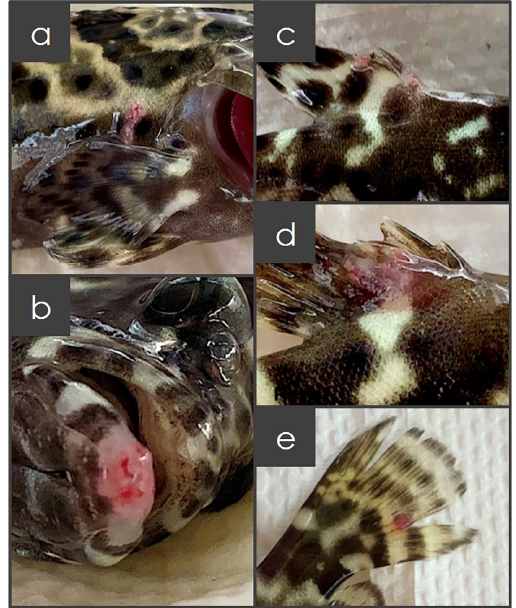
Figure 1. Development of ulcer and lesions on the body ( a ), mouth ( b ), anal fin ( c ), dorsal fin ( d ) and caudal fin ( e ) of hybrid grouper that were susceptible to Vibrio alginolyticus experimental infection, comparable to the resistant hybrid grouper where no observable ulcer and lesion were recorded. The infection of V. alginolyticus on the selected healthy hybrid grouper was confirmed by applying the bacteria plating method. The fish mucus from resistant and susceptible groups was spread individually on marine agar and TCBS agar to confirm the presence of Vibrio in the fish. All the subjected samples, including the spleen of the dead fish, showed positive for Vibrio infection on the TCBS agar (Appendix A Figure A1). However, the bacterial load was not quantitatively analyzed. The immersion in the same concentration of bacterial suspension in controlled conditions and exposure time might have given similar bacterial exposure to the fish. The evaluation on the skin mucus protein of the susceptible and resistant groups showed viscosity variation. The susceptible group secreted much more and a viscous mucus than the resistant fish. The protein composition of the skin mucus between the infected group and control group was significantly different with the former showing more variable intensities of the protein bands (Appendix A Figure A2). 3.2. Skin Mucus Proteome Profiling and Differential Expression Analysis The label-free shotgun proteomic analysis using LCMS identified a total of 1488 proteins in the skin mucus samples. Out of the 1488 proteins, 3, 2 and 8 proteins were found to be exclusively expressed in the control, resistant and susceptible groups, respectively (Figure 2). The identified putative proteins are listed in Table 1.